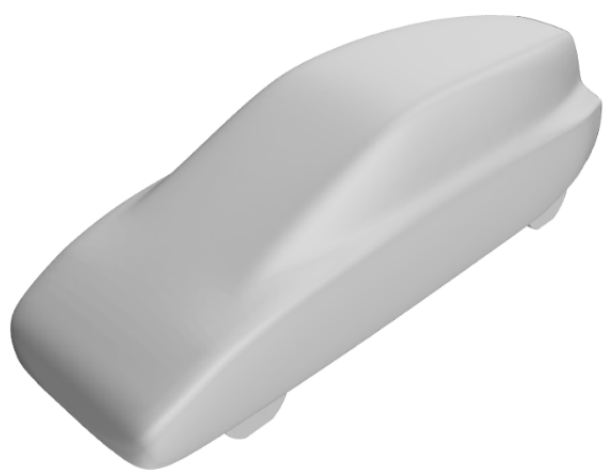
Figure 3. ASMO geometry.